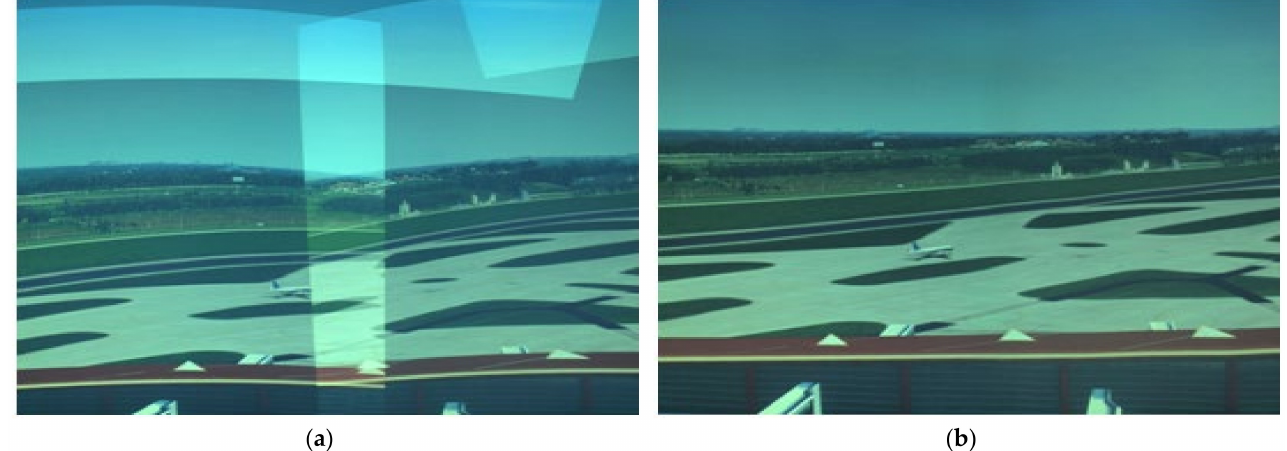
Figure 18. Contrast in a multi-projector system: ( a ) before geometric correction, and ( b ) after geometric correction.